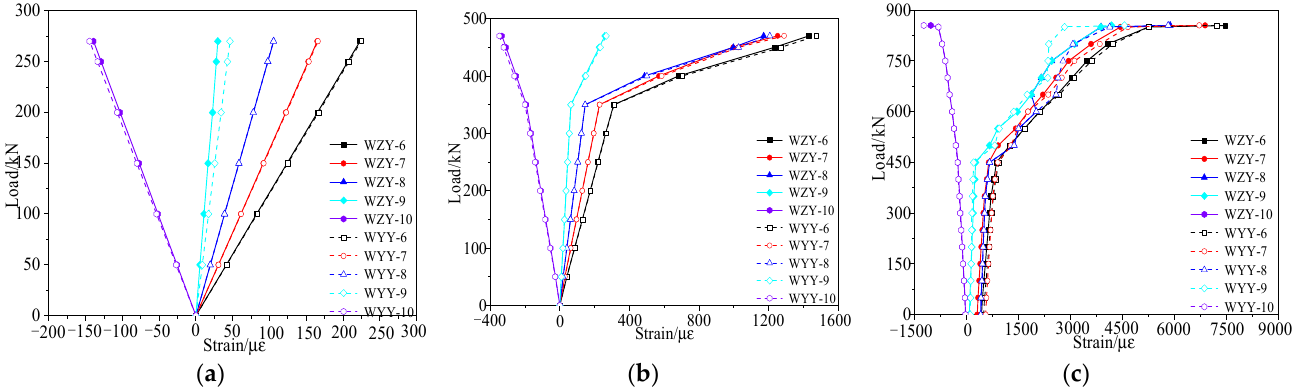
Figure 12. Strain vs. load curve of the concrete web at midspan of the undamaged test box girder. ( a ) Elastic stage; ( b ) Working stage with cracks; ( c ) The failure stage.